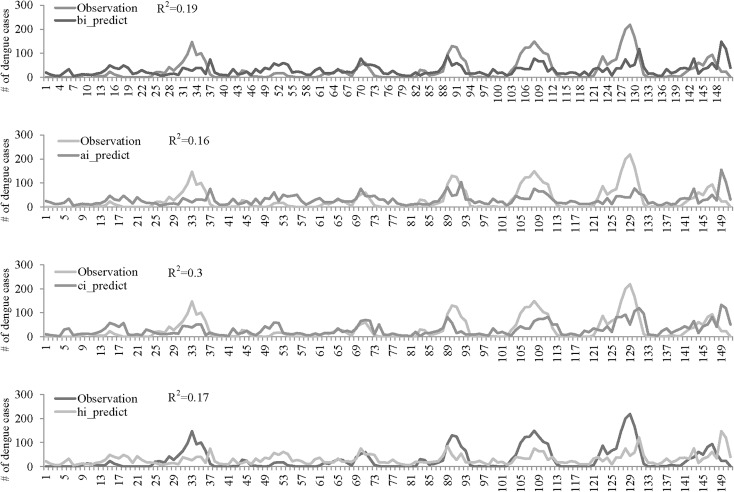
The weekly number of dengue cases from 2005 to 2012 based on the observation (solid line) and prediction (dahs line) from each vector index model including Model-BI: Breteau index model (A), Model-AI: adult A. aegypti index model (B), Model-CI: Container index model (C) and Model-HI: House index model (D).The values of coefficient of determination (R-square) from each vector index model were also indicated.